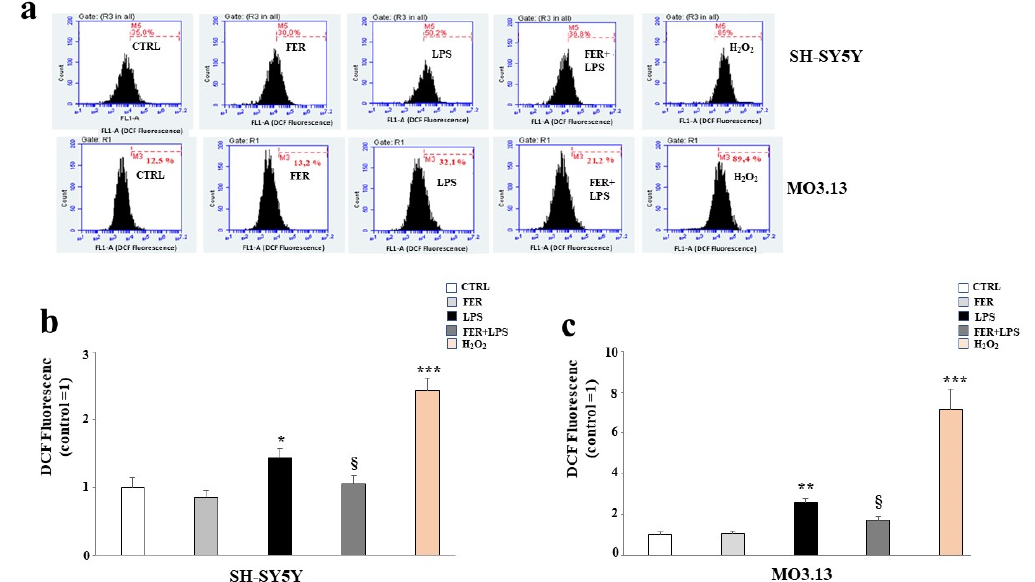
Figure 5. Oxidative profiles in SH-SY5Y and MO3.13 cells: evaluation of ROS accumulation. Co-cultured neurons and oligodendrocytes were treated with LPS or pre-treated with FER and subsequently exposed to LPS, as described. At the end of the treatment, ROS accumulation was assessed by flow cytometry. The results are illustrated in Figure 5. In panel ( a ), the plots for each treatment are displayed as indicated. M5 and M3 are the markers that were arbitrarily designed to determine variations in fluorescence and correspond, respectively, to the fifth and third quantifications carried out. A shift to the right among the cell population indicates an increase in fluorescence and ROS compared to the control, while a shift to the left indicates a reduction in fluorescence and ROS. In both cell lines, H 2 O 2 was used as the positive control. Panels ( b , c ) show the relative quantification obtained by fixing a value for an untreated cell as 1 and comparing the values to those of all other samples. A representative experiment from the three independent experiments that indicates the same results is also displayed. Values are expressed as the mean ± standard deviation (sd). * denotes p < 0.05 vs. the control; ** denotes p < 0.01 vs. the control; *** denotes p < 0.001 vs. the control; § denotes p < 0.05 vs. LPS. Analysis of Variance (ANOVA) was followed by a Tukey–Kramer comparison test.